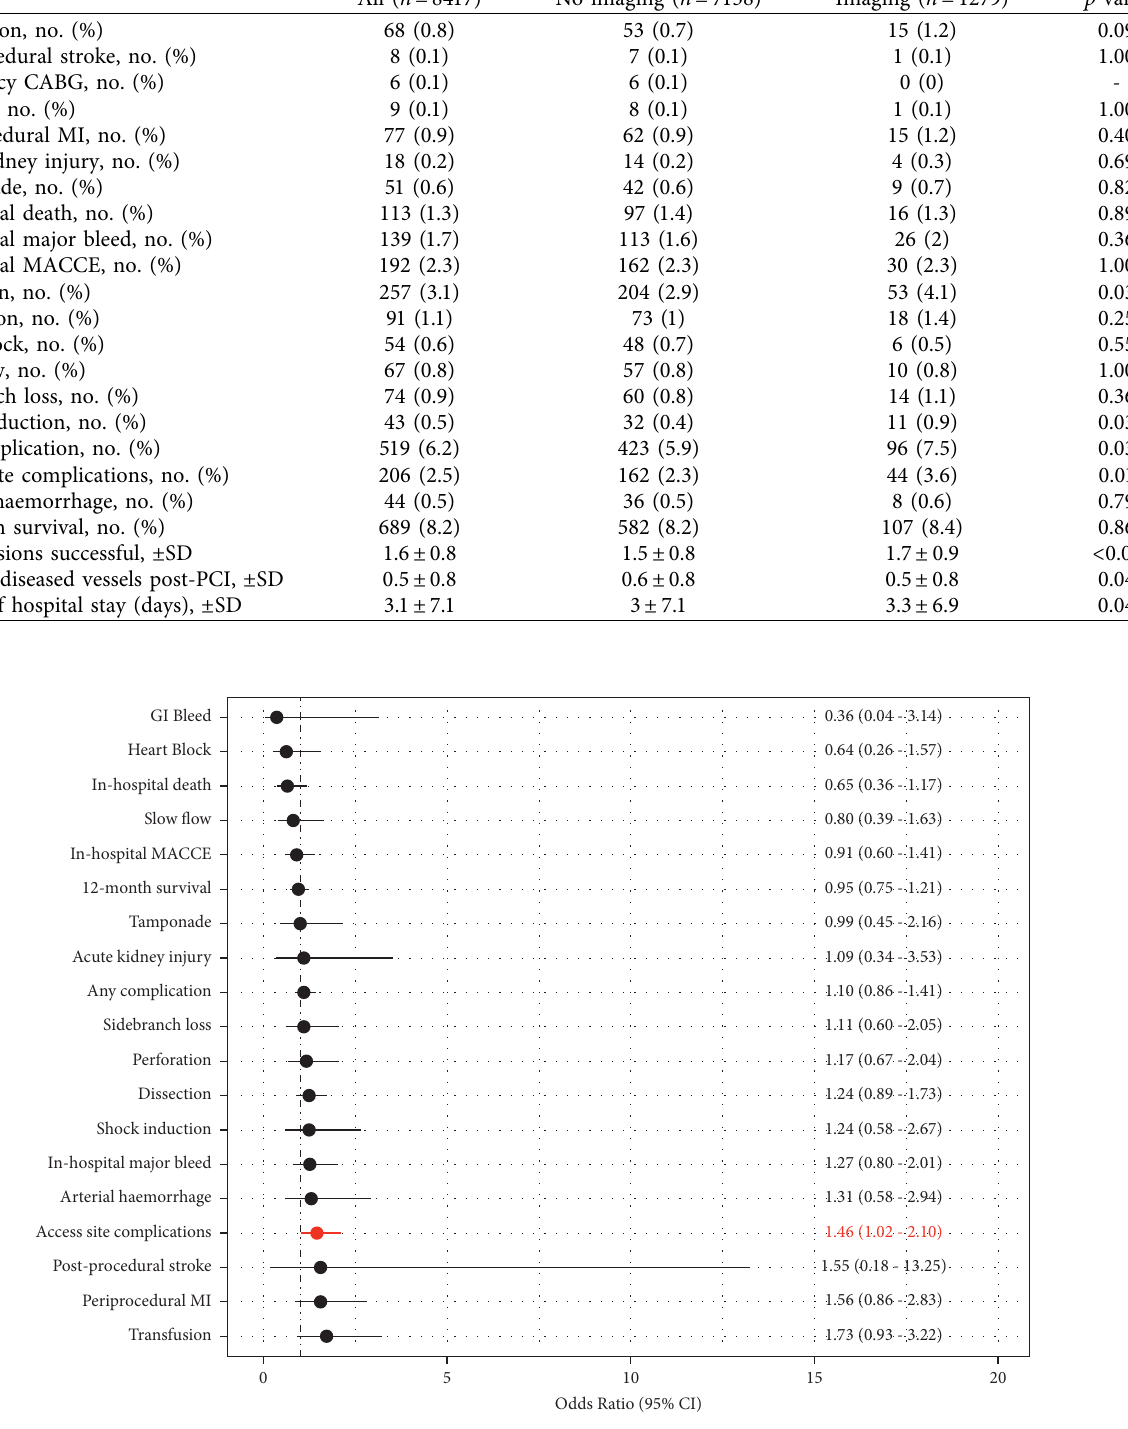
Table 3: Crude outcomes by intracoronary imaging use in patients undergoing RA-PCI in England and Wales, 2007 − 2014. Variable All ( n � 8417) No imaging ( n � 7138)